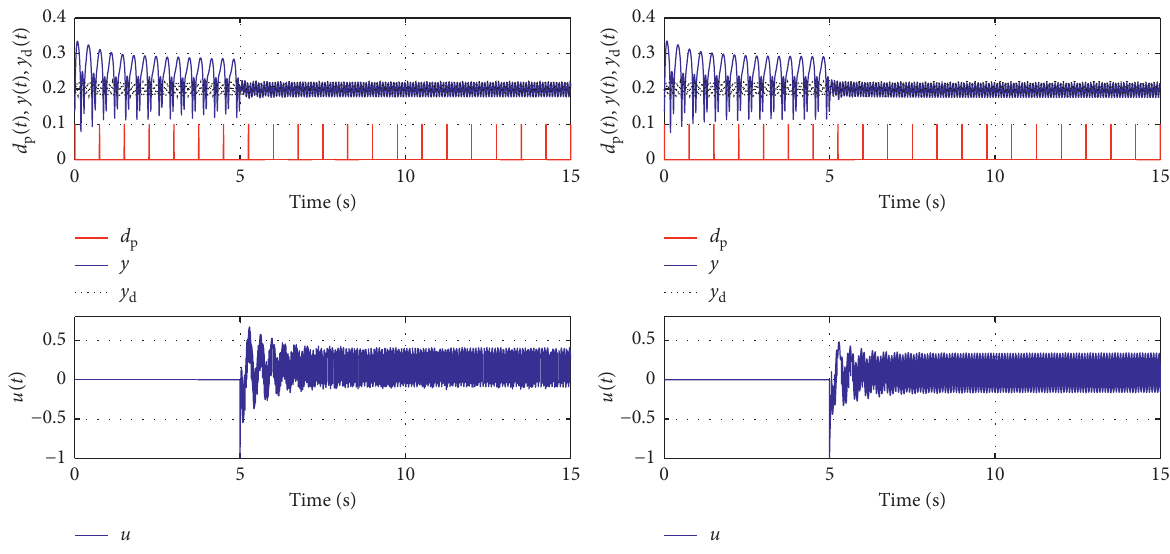
Figure 9: Control performance of IOSM and NN-FFOSM in case 1.